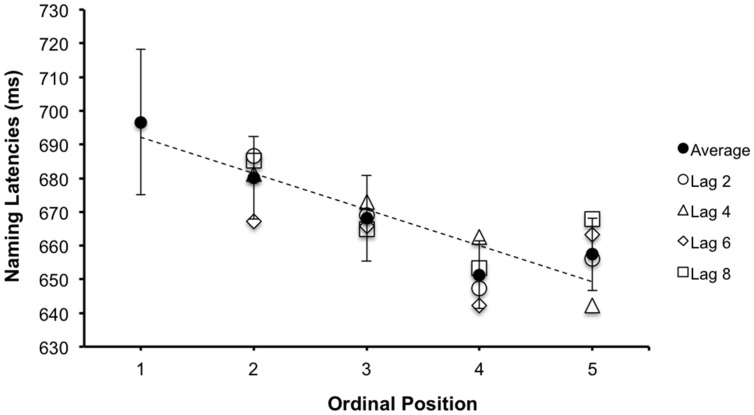
Mean correct superordinate categorization latencies as a function of ordinal position and lag in the continuous paradigm. Error bars represent 95% confidence intervals (CIs) calculated per Cousineau’s (2005) method.